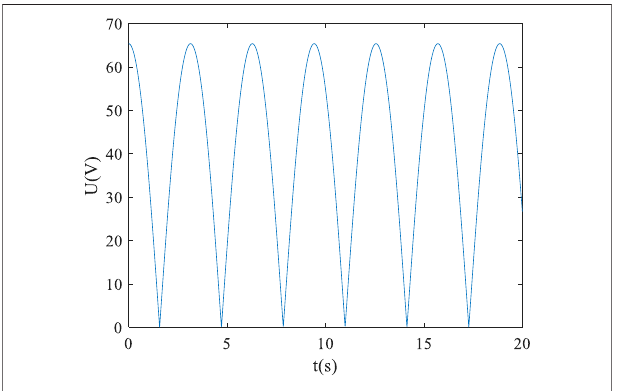
FIGURE 9 | P-t curve of wave energy